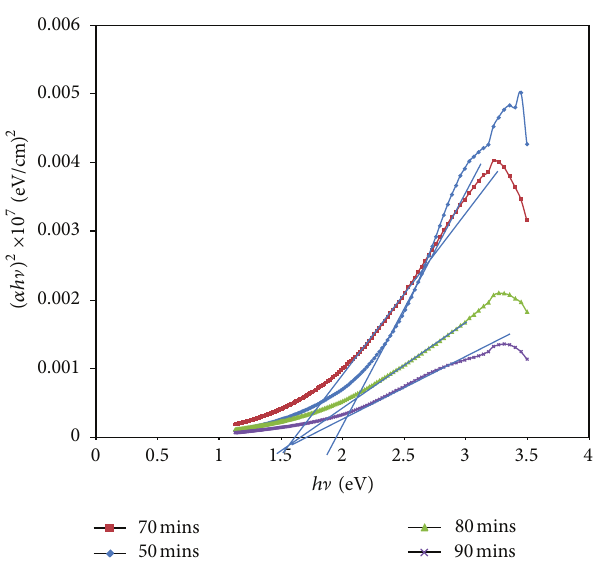
Figure 11: Direct band gap